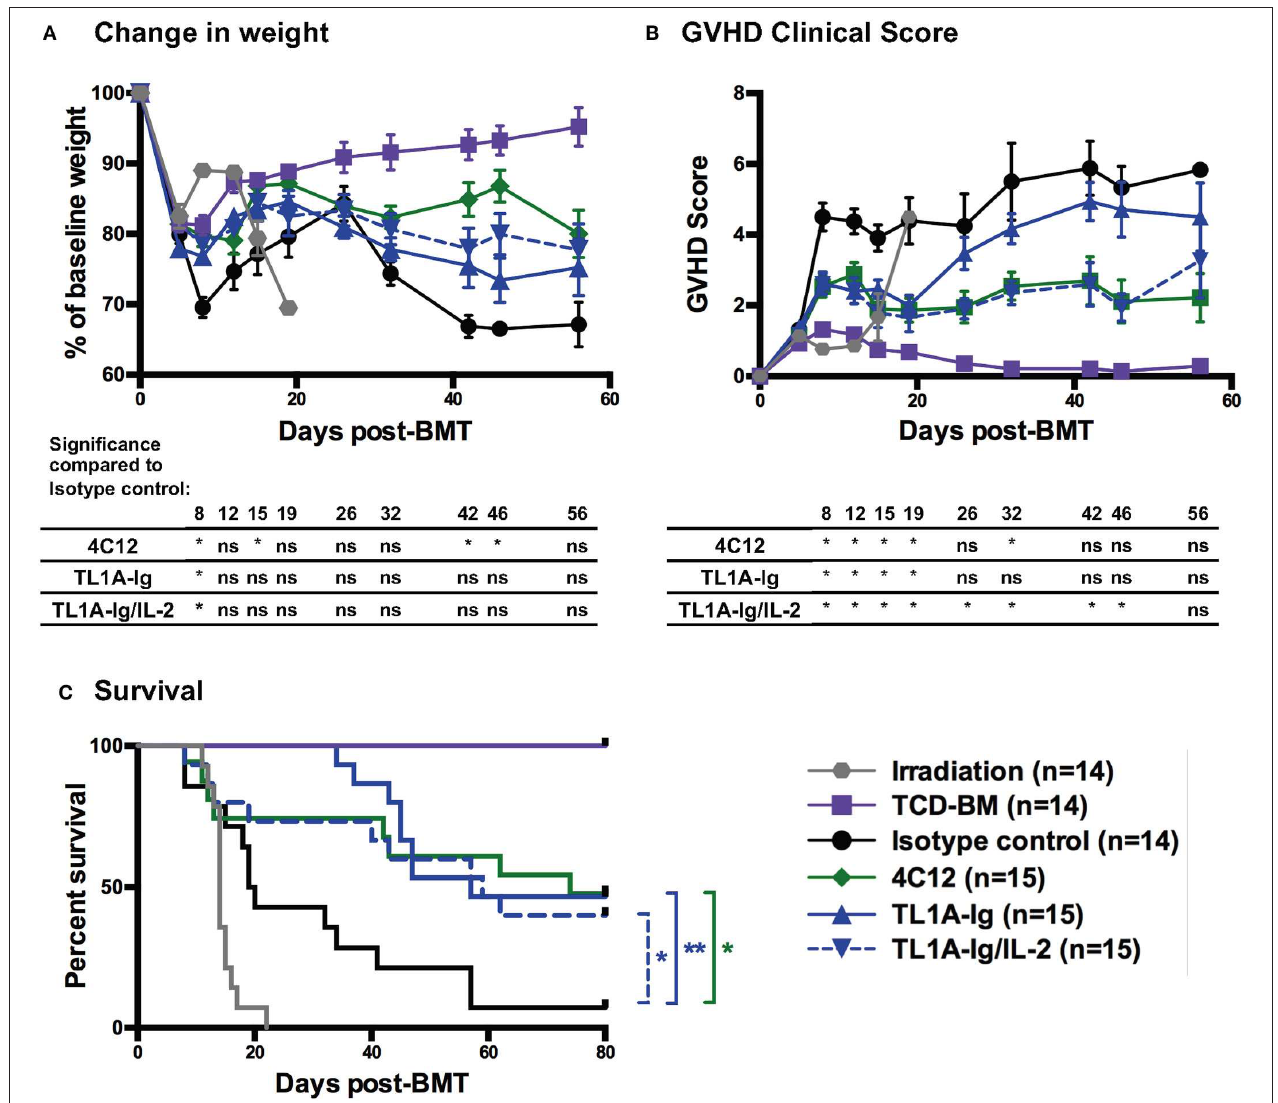
FIGURE 6 | Donor treatment with DR3 agonistic antibody (4C12) or fusion protein incorporating the endogenous ligand (TL1A-Ig) with or without IL-2 leads to a reduction in acute GVHD severity. T cells were isolated from donor mice (C57Bl/6) treated with DR3 agonists on day 7 of the treatment regimen and injected into Balb/c recipients along with T cell depleted bone marrow as in Materials and Methods. GVHD was assessed by measurement of (A) weight loss, (B) GVHD clinical score, and (C) survival. (Shown are the mean and SEM for each group over time. * p < 0.05 and ** p < 0.01 as compared to isotype control, (A,B) multiple student t -tests with Holm-Sidak correction and (C) log-rank test). Results are combined from 3 independent experiments. TCD-BM, T-cell depleted bone marrow only control.